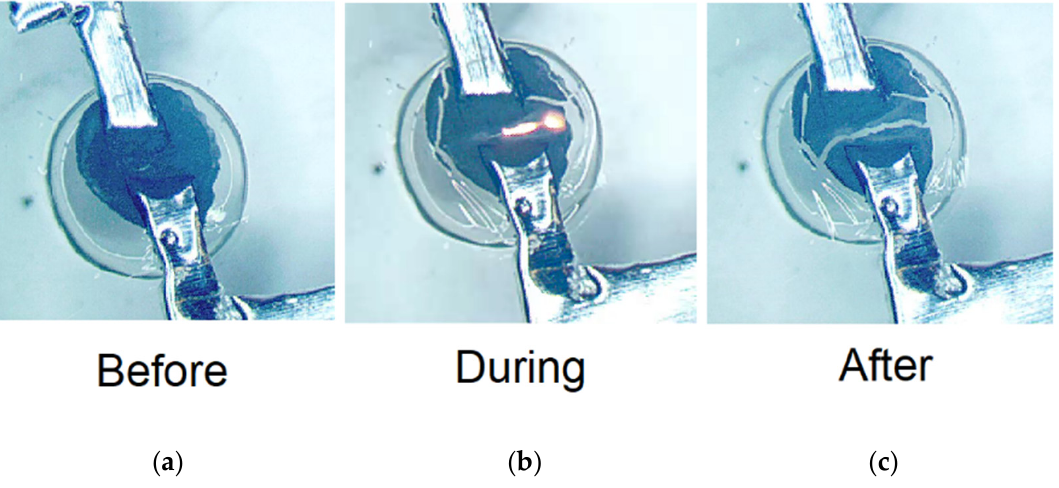
Figure 6. Explosive decomposition of well membrane (45× optical magnification) ( a ) before activation; ( b ) during activation; ( c ) after activation.